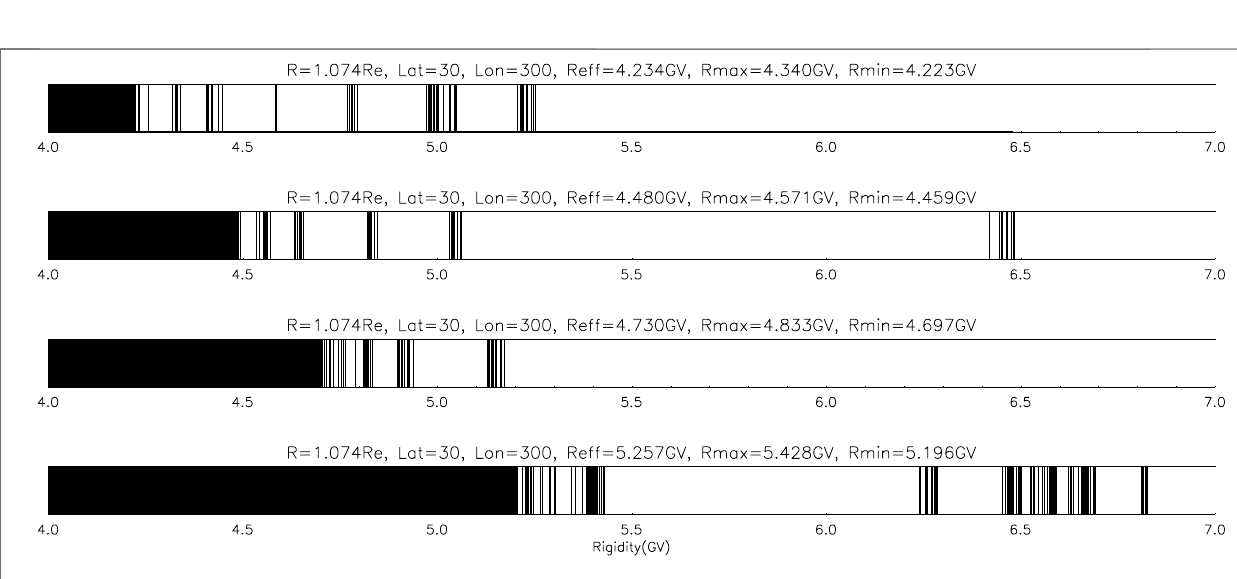
are the geomagnetic poles. The data are from the article by Alken et al. (2020). There are signi fi cant differences between the two due to the non-dipolar structure of the Earth ’ s magnetic fi eld. For more than a century, the change of the dip poles is more obvious than that of the geomagnetic poles. Usually, when the interplanetary and magnetospheric coupling mechanism is studied, the geomagnetic poles are used, as they can be used to specify the relative orientation of the Earth ’ s magnetic fi eld with respect to the Sun.